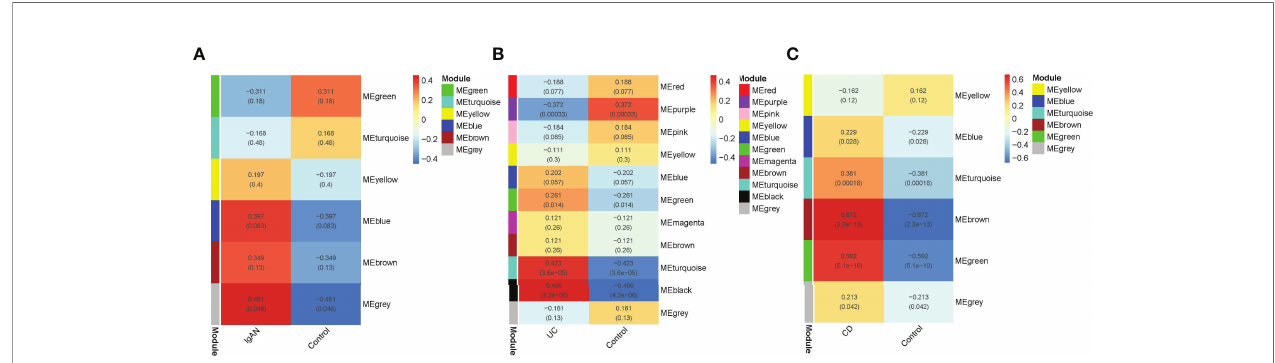
FIGURE 6 | WGCNA analysis of IRGs. (A) : Module – trait relationships in IgAN. Each cell contains the corresponding correlation and -value. (B) : Module – trait relationships in UC. Each cell contains the corresponding correlation and p -value. (C) : Module – trait relationships in CD. Each cell contains the corresponding correlation and p -value. Modules with R > 0.4 and P < 0.05 were screened for